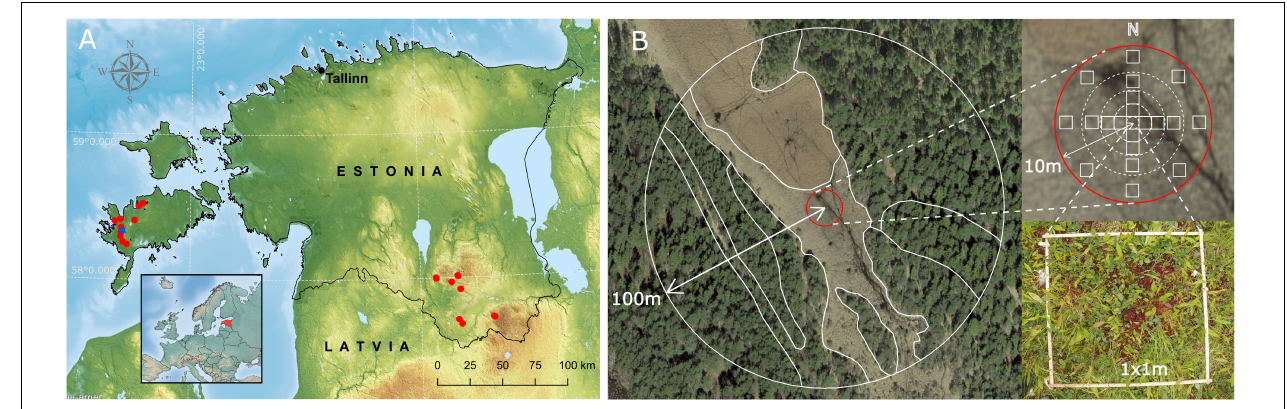
FIGURE 1 | Study area and sampling scheme. (A) Red dots indicate the sampled spring fens in southern Estonia and Saaremaa Island. Blue star marks the location of a Kanna spring fen used for sediment pollen based reconstructions. (B) The schematic overview of vegetation survey strategy modified from Bunting et al.